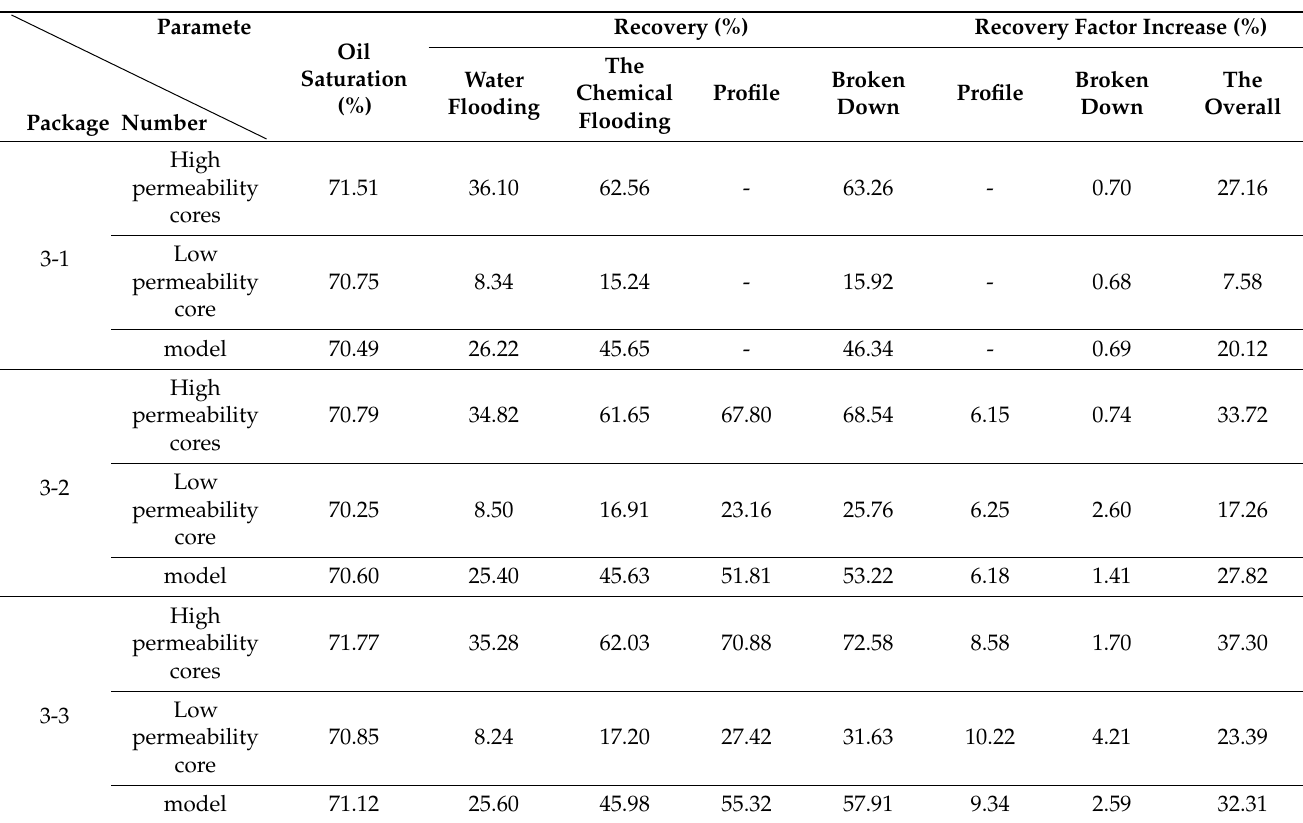
Table 4. Experimental data on oil-increasing and precipitation effect of the chemical flooding model “profile control + plugging removal” of recovery factor.